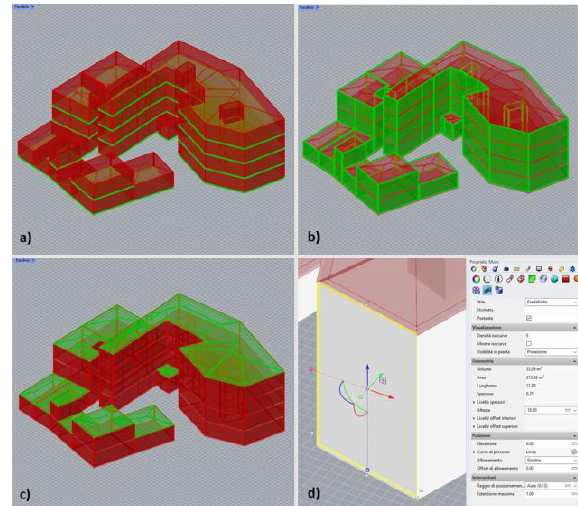
Figure 11 . LOD 2 CIM Model in Grasshopper. Focus on slabs (a), walls (b), roofs (c) and BIM attributes with VisualARQ plugin for Rhinoceros